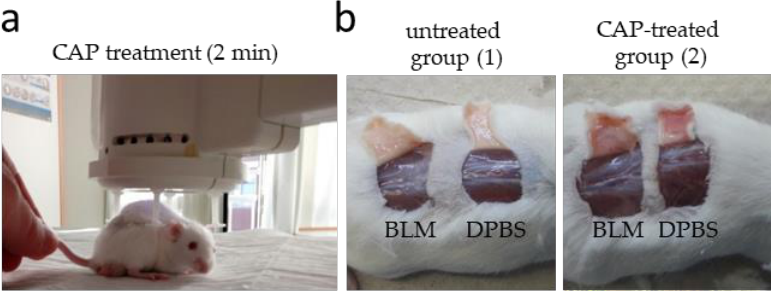
Figure 5. CAP treatment of mice and tissue sampling. Prior to CAP treatment, dermal fibrosis was induced in defined areas on the murine back by 100 µ L of BLM injection (500 µ g/mL) for 28 days. Corresponding control skin was obtained from the same animal by 100 µL of DPBS injection for 28 days to exclude reactions due to injection into the affected skin. Afterwards, the backs of the mice remained untreated (group 1) or were treated with CAP for 2 min (group 2) using the MicroPlaSter β ® device. In total, the animals received 10 CAP treatments five times per week as shown in ( a ). After 10 day treatment with CAP, all mice, including the untreated ones, were killed, and the corresponding skin areas were removed ( b ). Biomedicines 2021 , 9 , x FOR PEER REVIEW